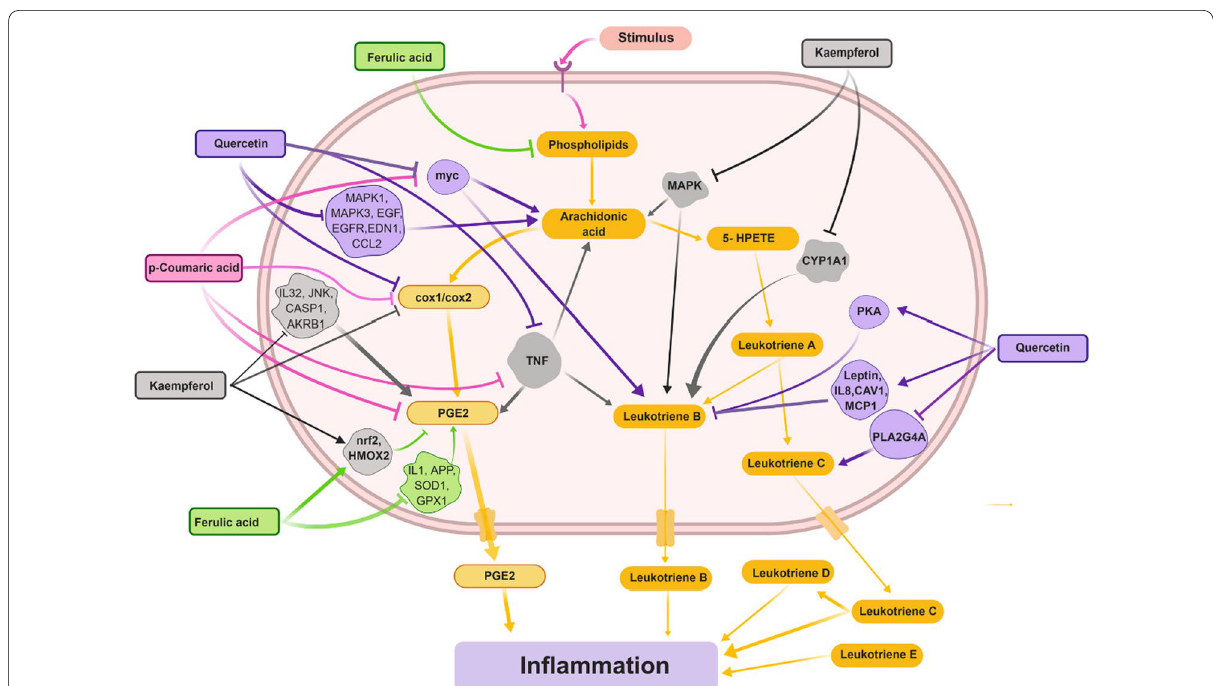
Fig. 2 Possible mechanism of action of BC extracts to reduce inflammation in humans. In the BC extracts, phenols and polyphenols, e.g., ferulic acid, p-coumaric acid, kaempferol, and quercetin, inhibit the signaling molecules, stimulation of which may directly or indirectly result in inflammation. Proteins linked to inflammation participate in several canonical pathways underlying a range of biological activities. Ingenuity pathway analysis (IPA) identified that the BC extracts’ components could target many of these proteins (Additional file 1: Table S1) and control inflammation. Arrows ( ) indicate direct stimulatory modification, whereas light-up signs ( ┬ ) indicate an inhibitory modification. The names of the ↓ proteins followed the Hugo nomenclature, NCBI Entrez, UniProtKB/Swiss-Prot